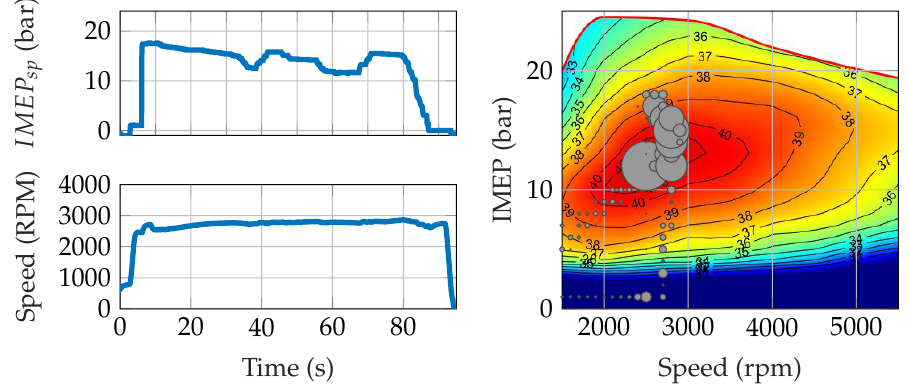
Figure 6. Hybrid vehicle typical transient trajectory for strategy validation.